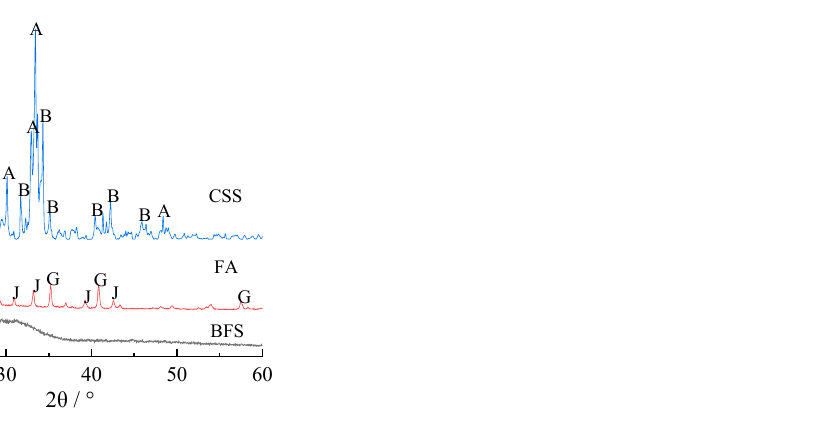
Table 2. Dosage of sodium silicate solution and distilled water for different composite alkali-activated cementitious